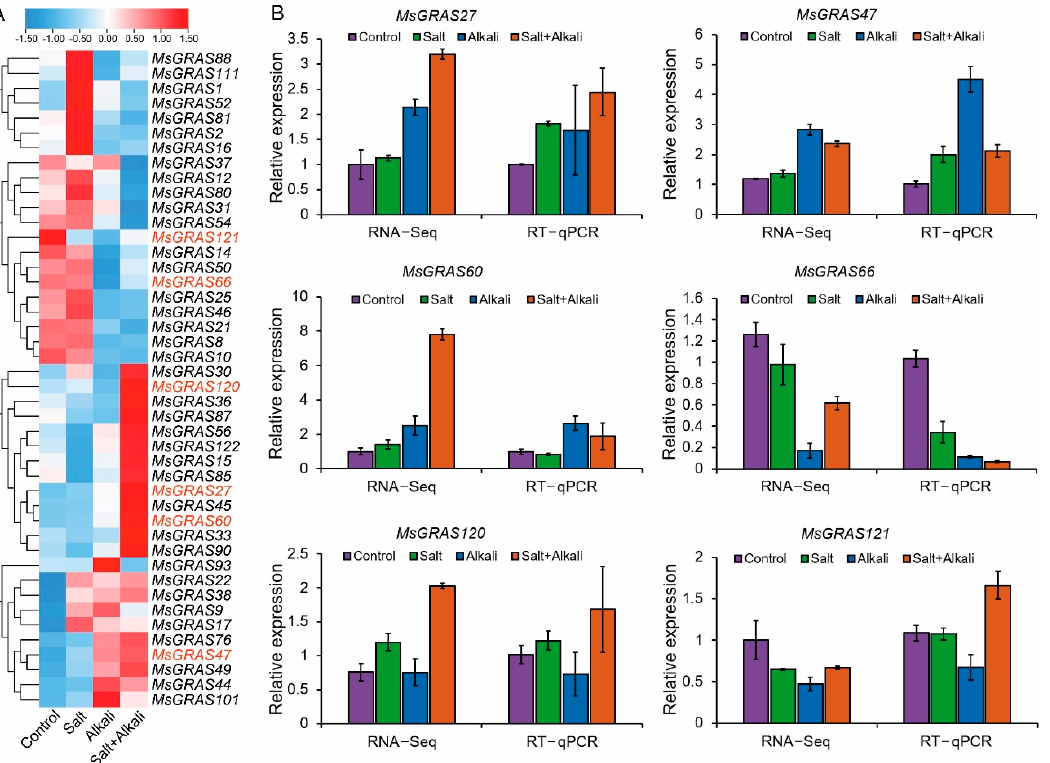
Figure 5. Expression profiling of MsGRAS genes and verification by RT-qPCR. ( A ) Expression profiling of MsGRAS genes under salt, alkali, and mixed salt-alkali stresses. The transcriptome sequencing was performed using Miscanthus leaves subjected to salt (0.3M NaCl + 0.3M Na 2 SO 4 ), alkali (0.315M Na 2 CO 3 + 0.315M NaHCO 3 ), and salt-alkali (0.15M NaCl, 0.15M Na 2 SO 4 , 0.15M Na 2 CO 3 , and 0.15M NaHCO 3 ) treatments for 6 h. The genes in red were selected for RT-qPCR verification. ( B ) Comparison of RT-qPCR and RNA-seq analyses of six MsGRAS gene expression in salt, alkali, and mixed salt-alkali treatments. The bars represent the standard error (SE) of three biological repeats.